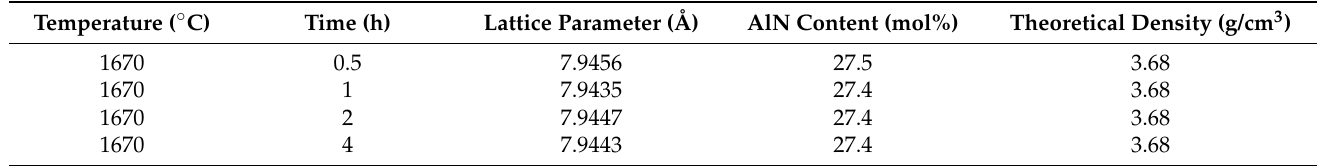
Table 2. Lattice parameters, AlN content and theoretical density of AlON synthesized at 1670 ◦ C for various